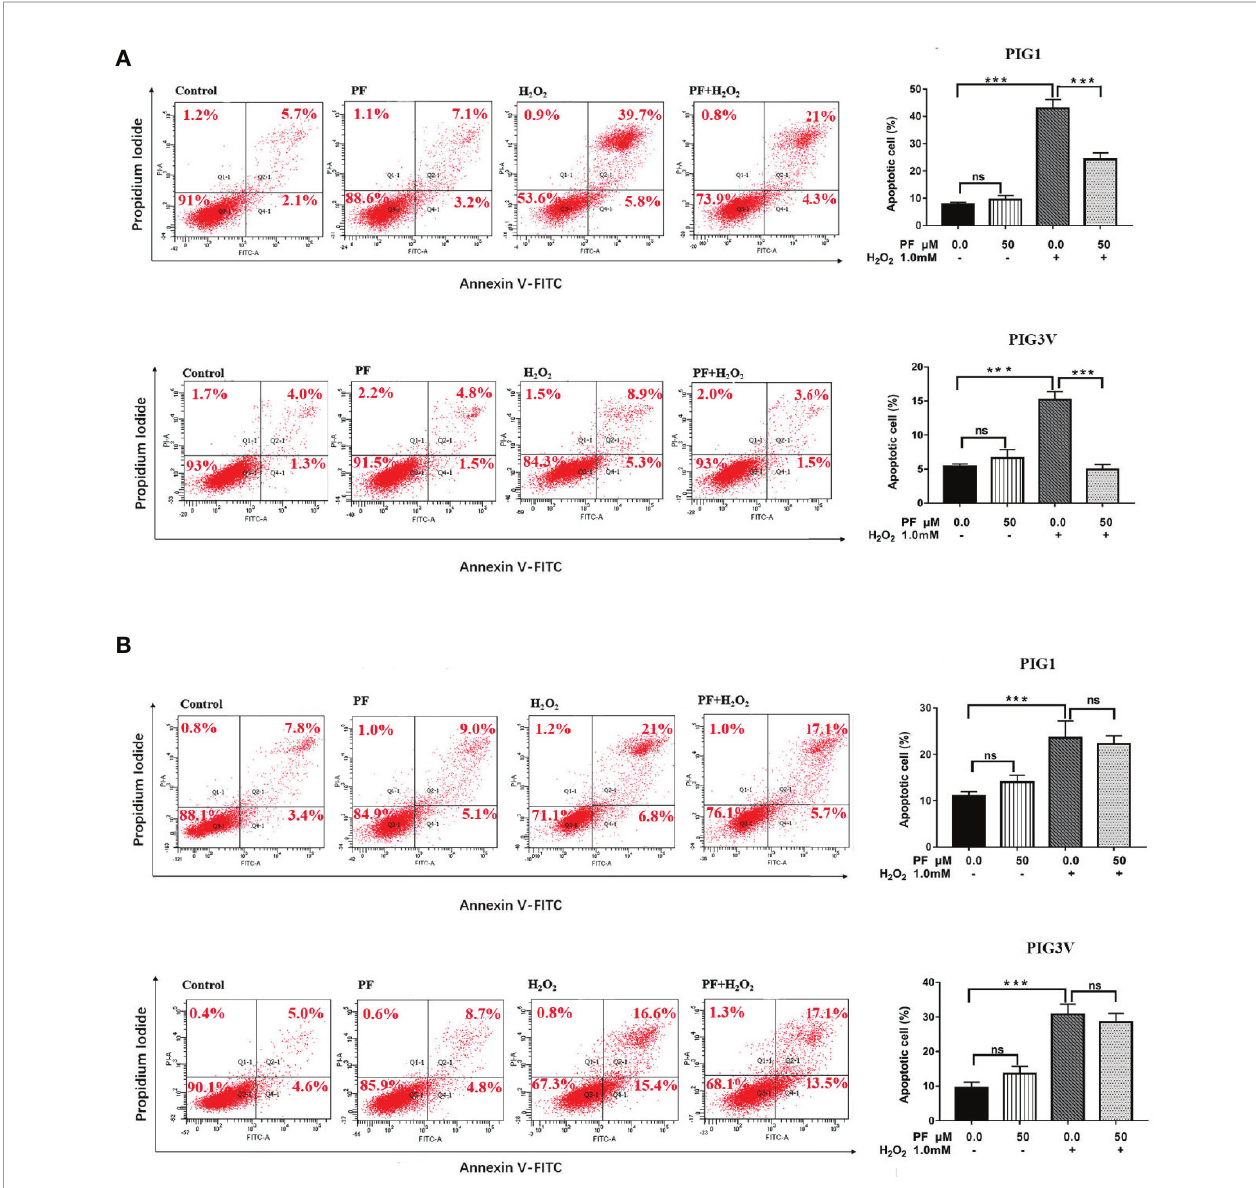
FIGURE 3 | PF ameliorates H 2 O 2 -induced apoptosis in melanocytes. Melanocytes were treated with PF for 24 h (A) or 48h (B) and then treated with H 2 O 2 for another 24 h. The cell apoptosis was analyzed by the fl ow cytometry and each fi gure shown was representative image from three independent experiments, the percentages of cells apoptosis were shown as the right bar graphs and the data were presented as the mean ± standard deviation across three independent experiments. *** P < 0.001. ns, not signi fi cant; H 2 O 2 , hydrogen peroxide; PF, Paeoni fl orin; h, hours; M,